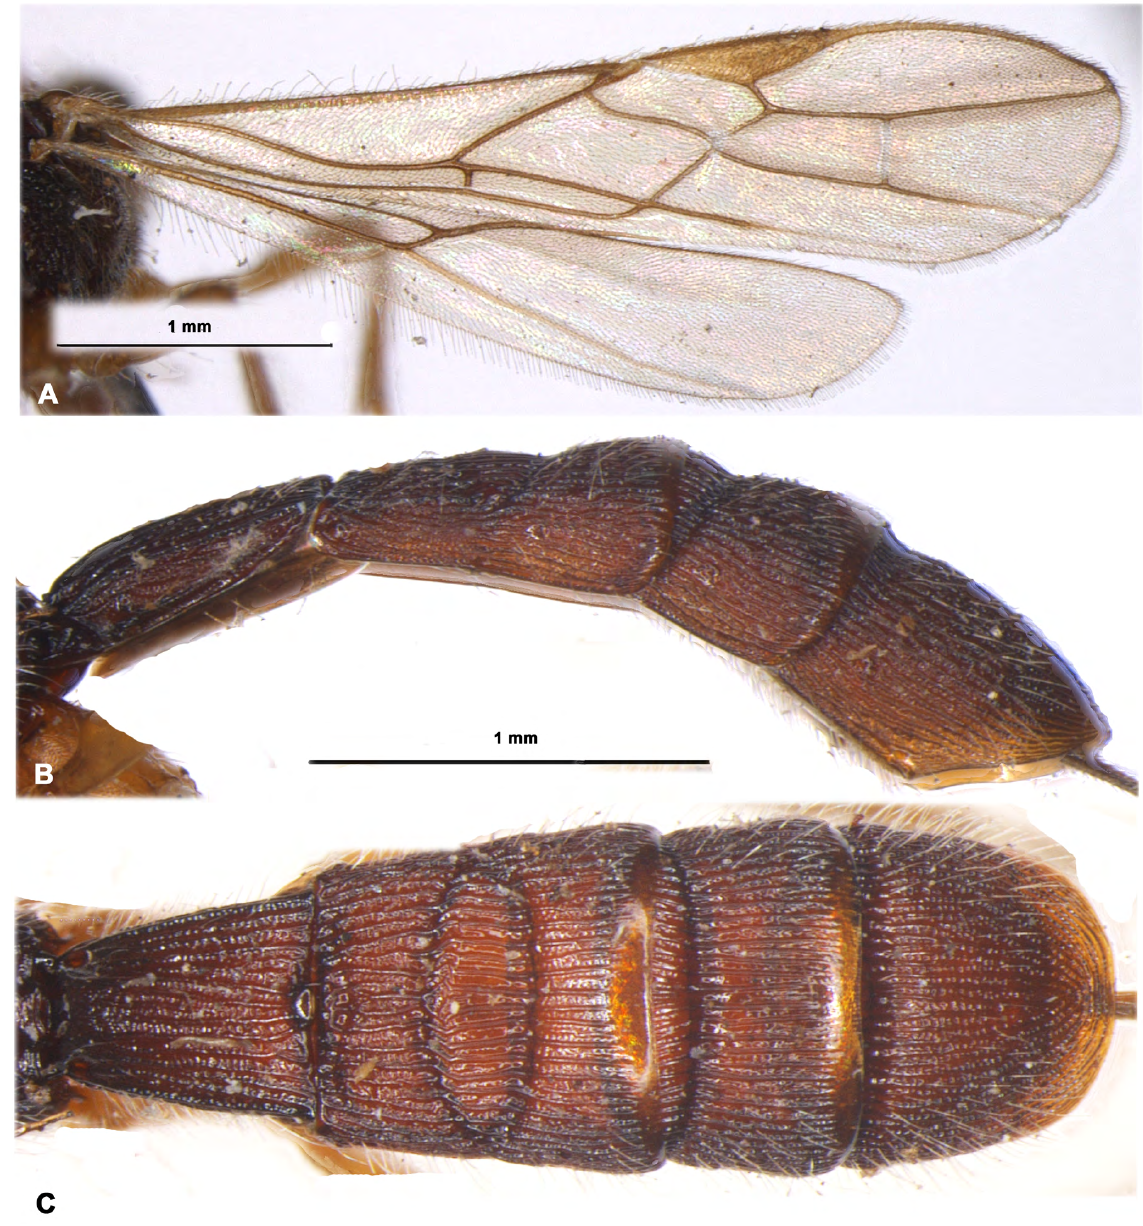
Fig. 9. Euryphrymnus testaceiceps Cameron, 1910, ♀, holotype, MHBG. A . Wings. B . Metasoma, lateral view. C . Metasoma, dorsal